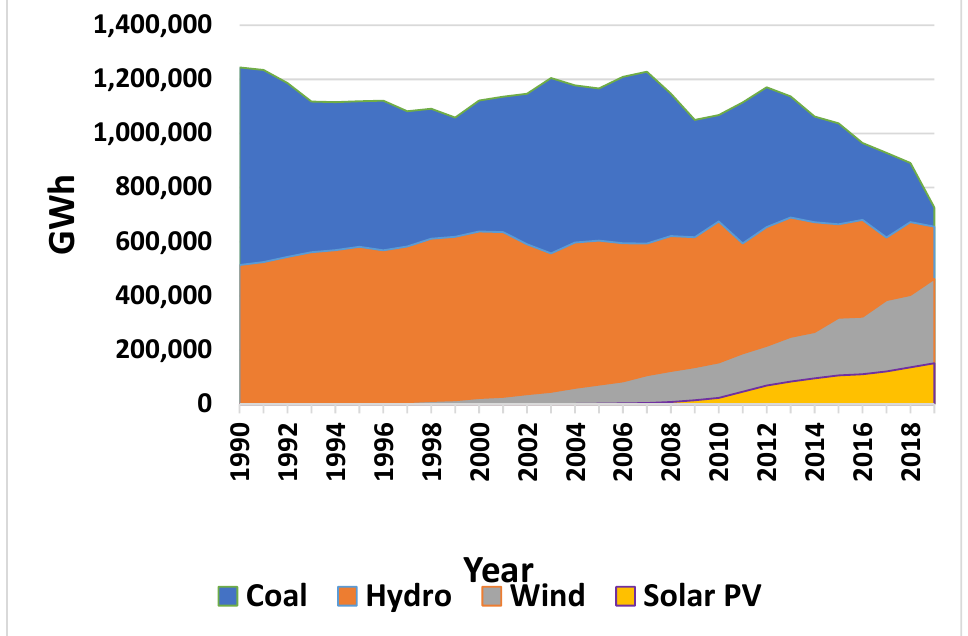
Figure 1. Europe’s electricity generation from 1990 to 2021 (modified from International Energy Agency ΙΕΑ [3]).